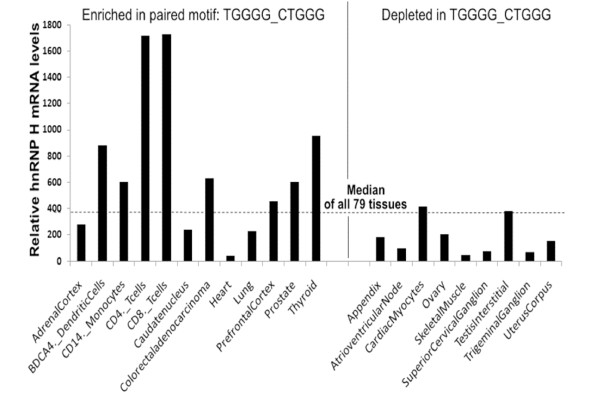
Motifs resembling hnRNP binding sites correlate with tissue-specific preferential expression of the hnRNP mRNA. Gene expression data were obtained from Su et al. [43]. Both 5-mers in the co-occurring pair TGGGG/CTGGG resemble the binding site of hnRNP H. P < 0.01, binomial test.